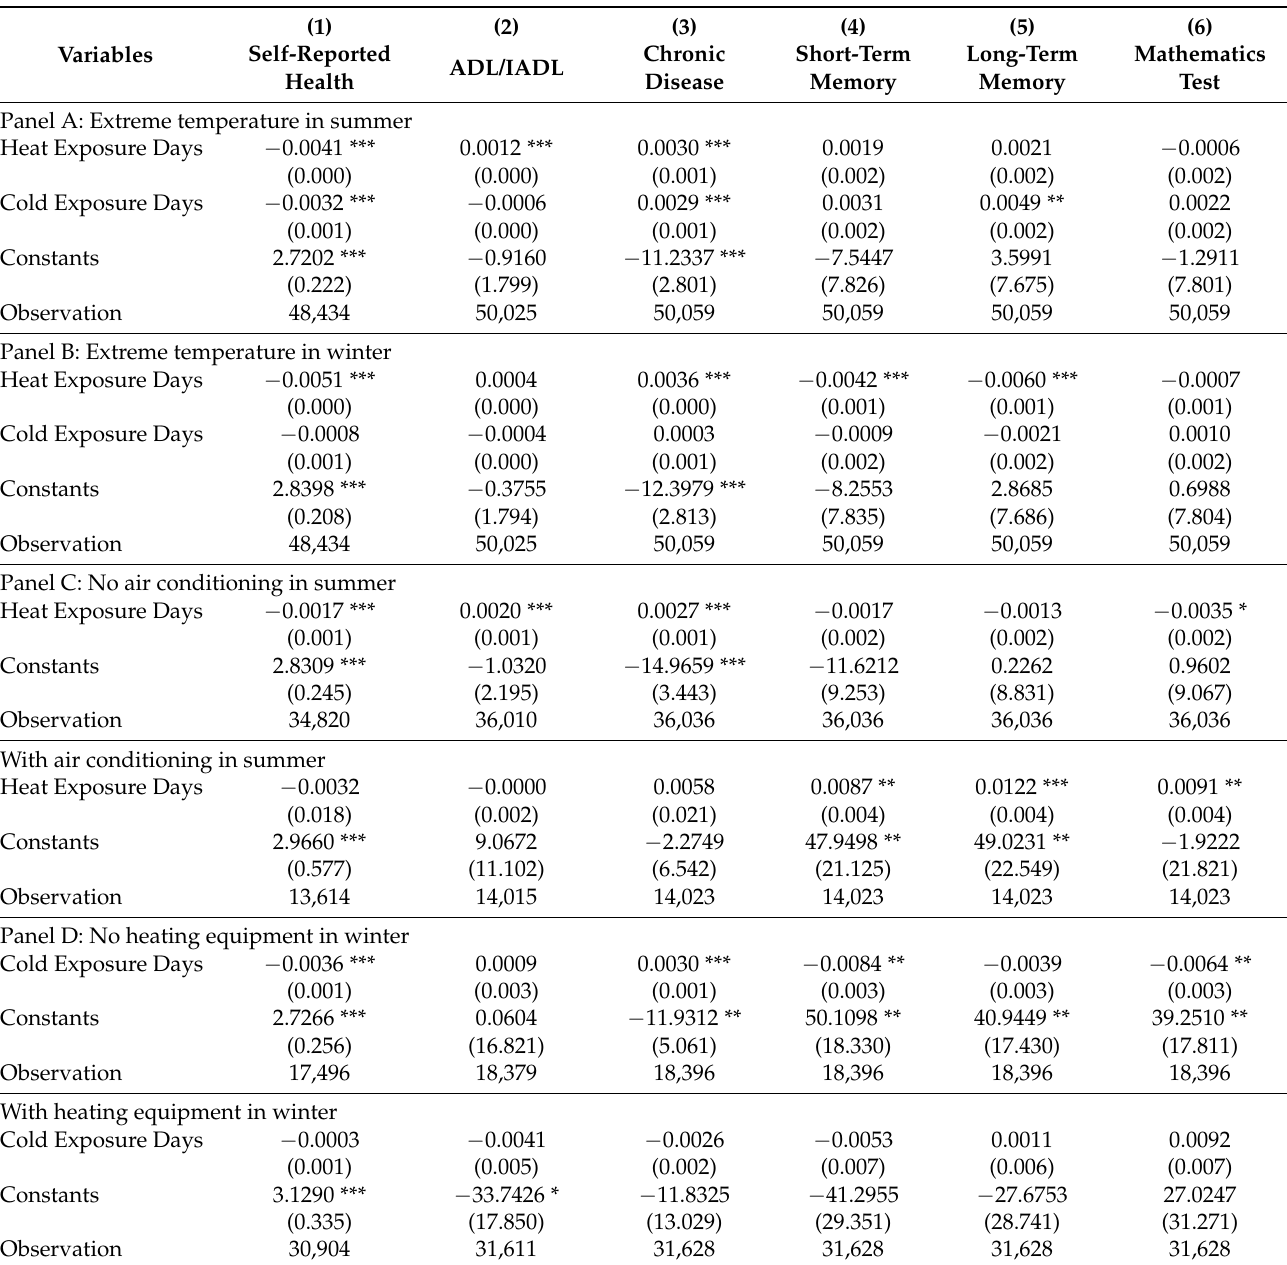
Table 3. Regression results of the adaptations